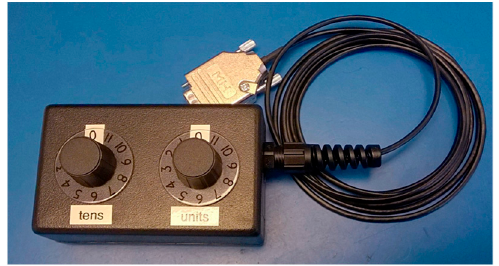
Figure 2. NovoTHOR randomising switch